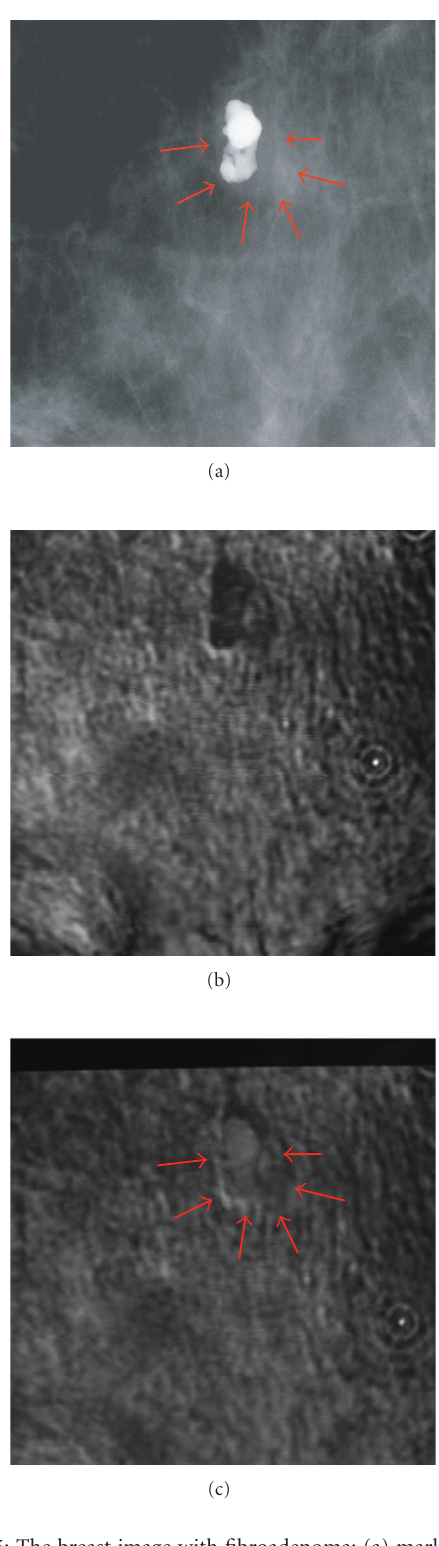
Figure 5: The breast image with fibroadenoma: (a) marked X-ray by an expert radiologist showing the fibroadenoma and the nearby calcification; (b) a 5 × 5 cm 2 VA image of a breast including a large calcification and nearby fibroadenoma; (c) the resultant registered VA images with focal point at 20mm from the CCD screen, “repro- duced with permission from